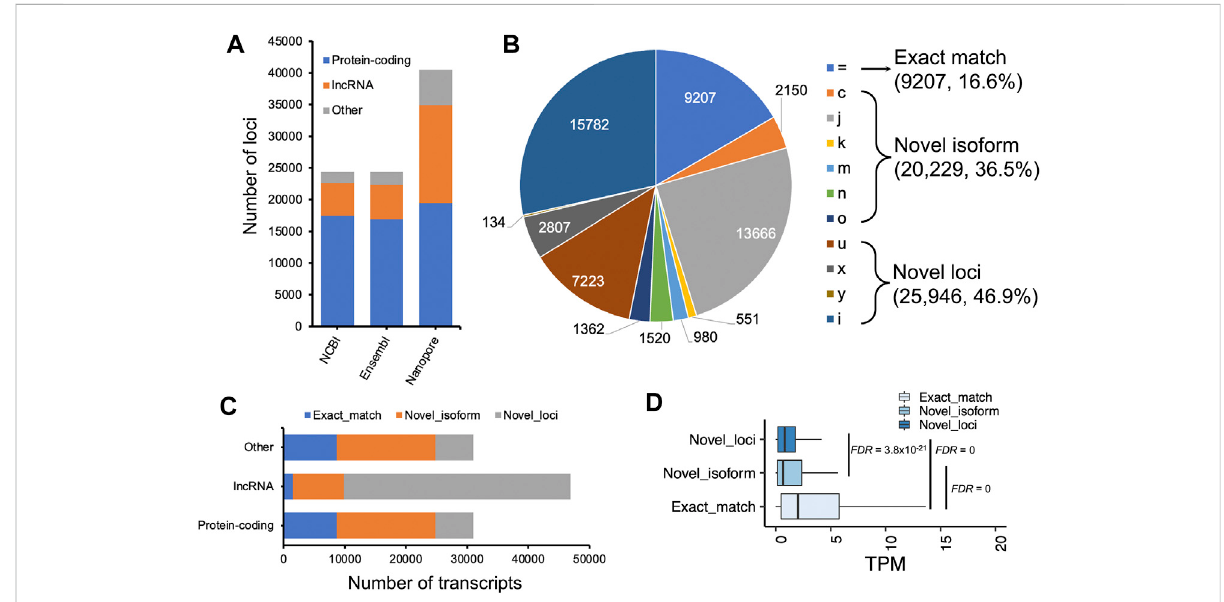
FIGURE 3 Characterization of assembled transcripts. (A) Number of loci in NCBI (V105), Ensembl (V102) and our annotations. (B) Pie chart depicting GffCompare types to Ensembl annotation (V102). (C) Number of transcripts as a function of protein-coding, lncRNA, and other non-coding loci. (D) Transcript expression measured as transcript per million (TPM) as a function of different types of transcripts classi fi ed by GffCompare tool. Exact match: GffCompare code “ = ” , which means the intron chains of our annotated transcripts can exactly match to reference annotations;Novel isoform:GffComparecodes ‘ c, ’‘ k, ’‘ j, ’‘ m, ’‘ n, ’ or ‘ o ’ , whichmeanspredictedtranscriptcannotmatchareferencetranscriptbut can match a reference gene; novel loci: GffCompare codes ‘ i, ’ ‘ u, ’ ‘ y, ’ or ‘ x ’ , which means predicted transcript cannot match either a reference transcript or a reference locus. The type ‘ y ’ only has 134 transcripts, a small proportion that is not visible in the pie chart. Student ’ t tests were carried out between two groups of transcripts, and p values were adjusted by using false discovery rate (FDR) method (Benjamini and Hochberg,